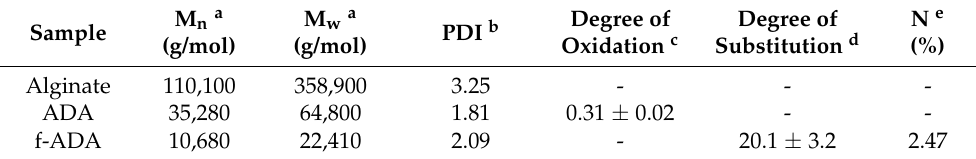
Table 2. The GPC results for alginate samples, the degrees of oxidation of ADA, and the degrees of substitution of